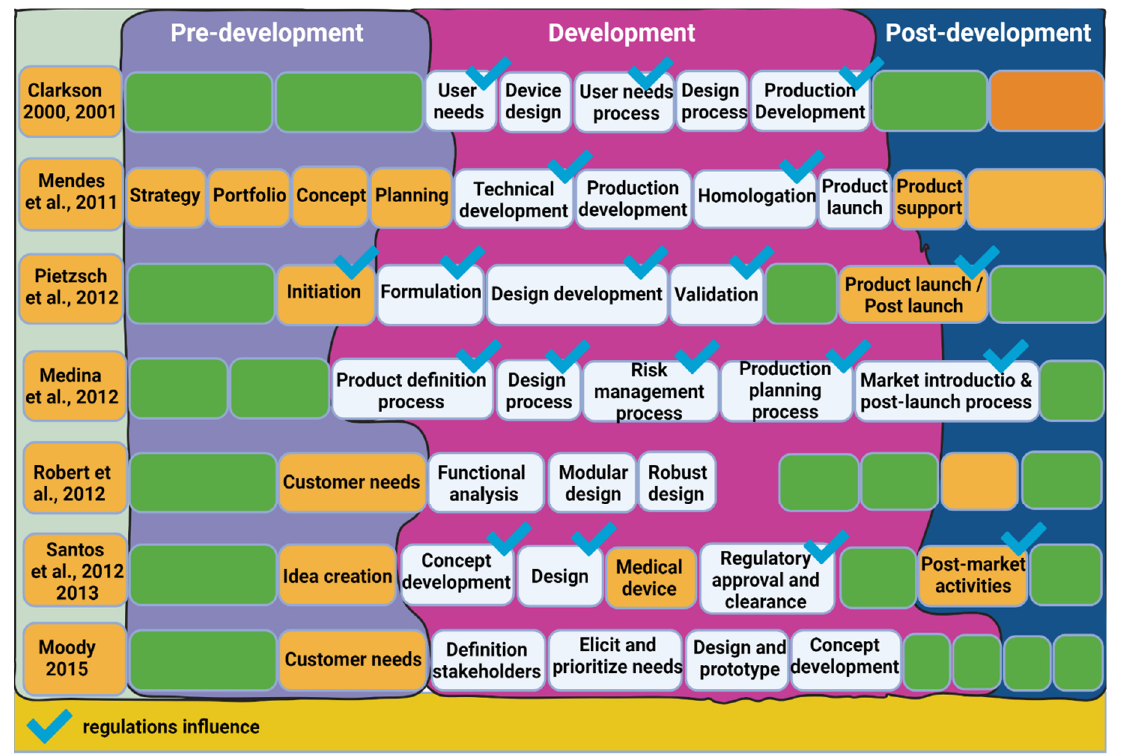
Figure 2. Overview of Medical device Development models from the Literature